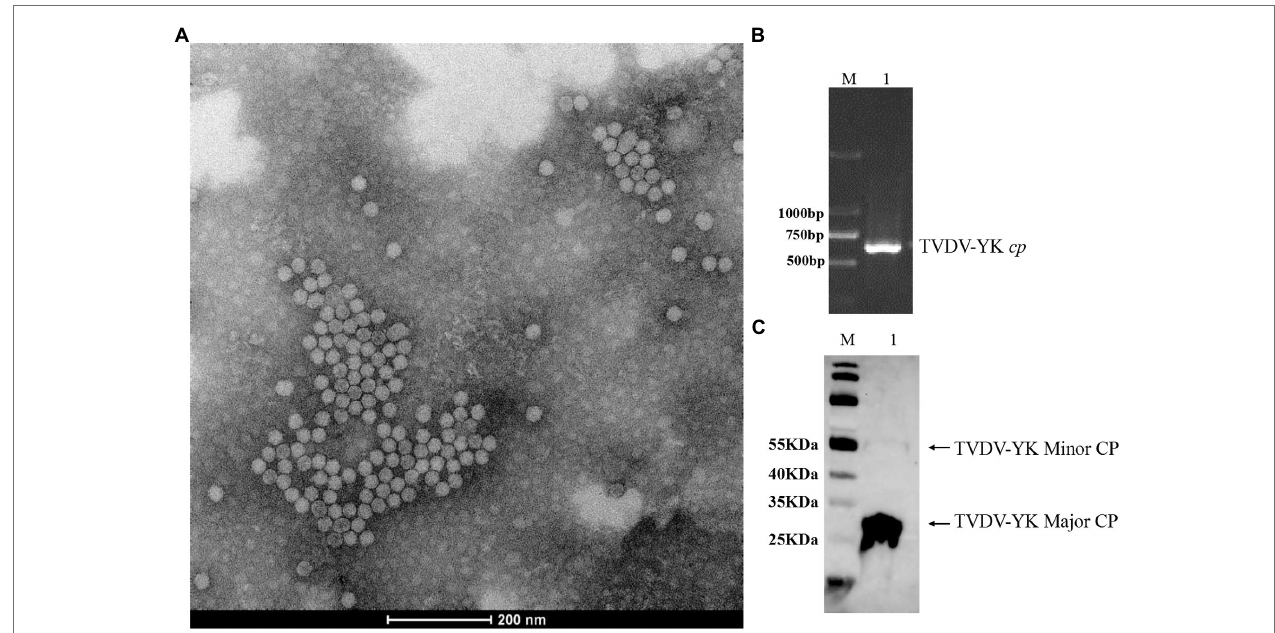
FIGURE 8 | Virions purified from Nicotiana benthamiana leaves infected by the TVDV-YK infectious clones, observed by TEM, and detected by RT-PCR and western blotting. (A) An electron microscopic image of TVDV-YK virions purified from TVDV-YK infected Nicotiana benthamiana leaves. The virions were negatively stained with 1% phosphotungstic acid and photographed under an electron microscope. Bar, 200 nm. (B) RT-PCR products from purified TVDV-YK virions. Lane M, DL 2000 DNA Marker. (C) Western blot detection of coat protein (CP) from the purified TVDV-YK virions using a polyclonal antibody specific for TVDV CP. Lanes M: 26616 protein ladder (Thermo Fisher Scientific, Waltham, MA, Unites